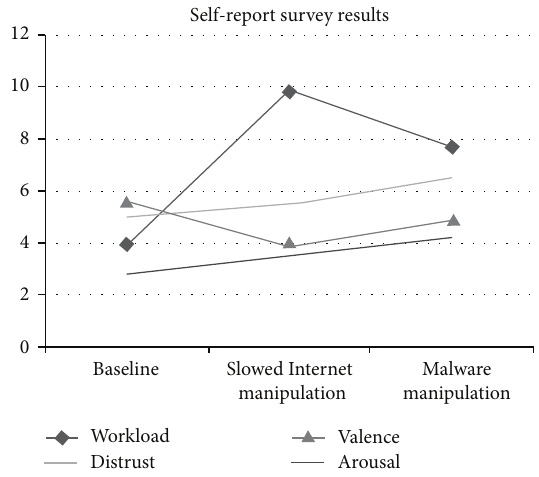
Figure 4: Self-report values after the baseline, slowed internet manipulation, and malware